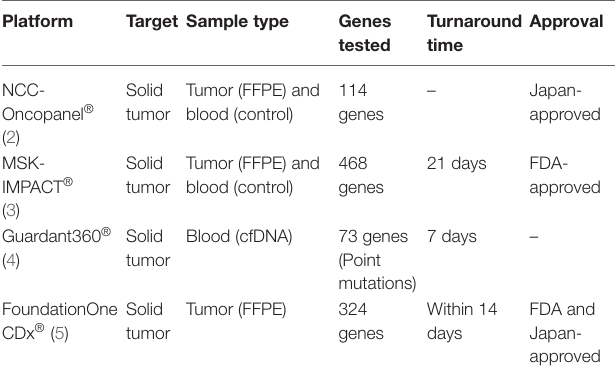
TABLE 1 | Comparison of the genomic tests NCC-Oncopanel ® , MSK-IMPACT ® , Guardant360 ® , and FoundationOne CDx ® .